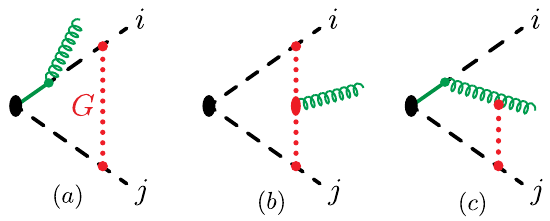
Figure 2 . Diagrams that give imaginary part of one-loop one real emission amplitude. Additional diagrams are obtained by flipping i ↔ j in (a) and